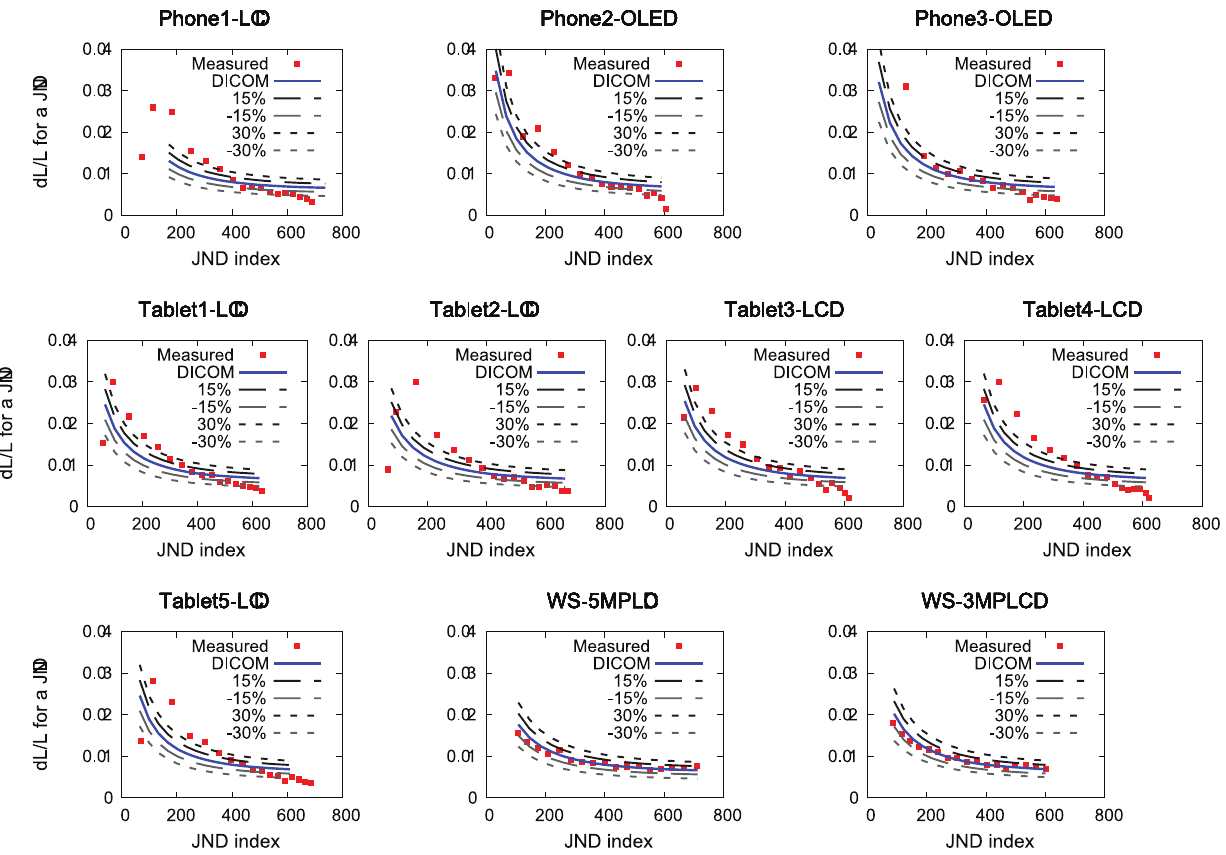
Figure 2. Contrast responses at 18 luminance levels as a function of JND index. The measured contrast responses at each step and the expected contrast responses from DICOM GSDF with the 15 and 30% tolerance bands are depicted.